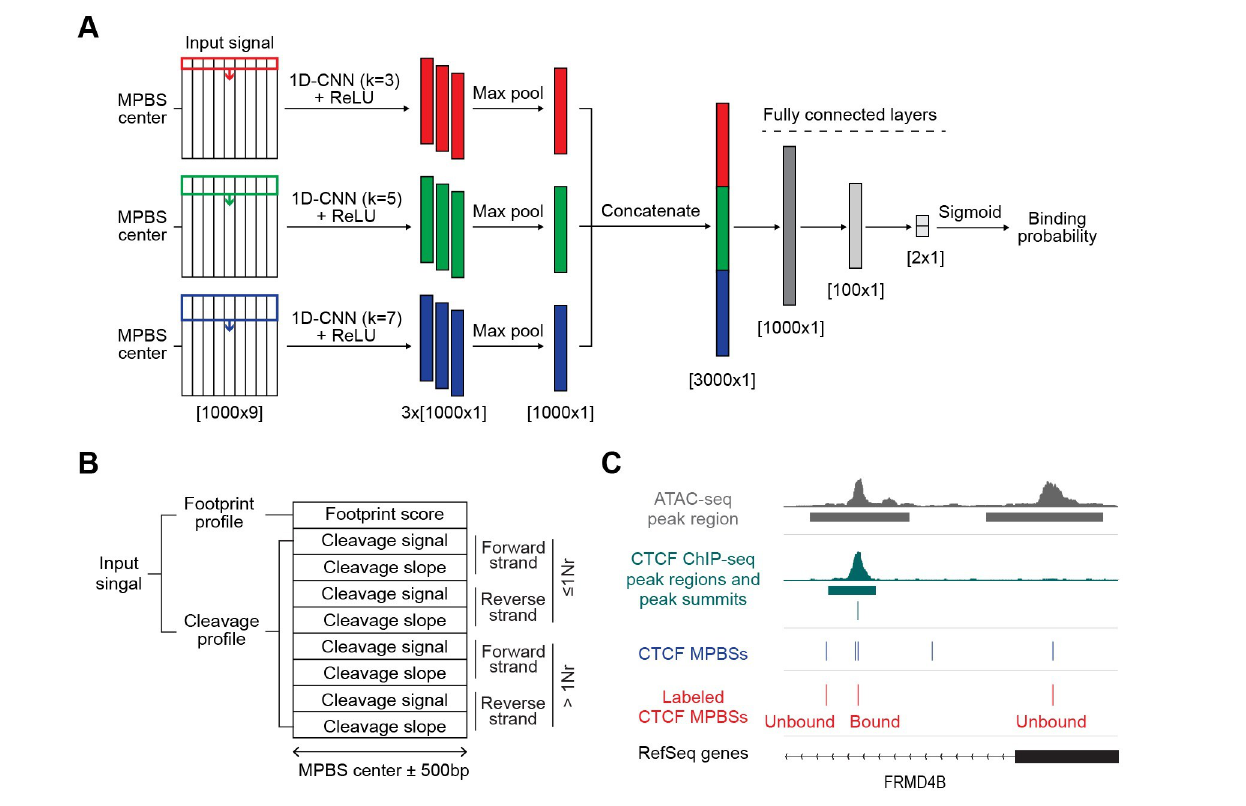
Fig 1. TAMC model and input signal. (A) Architecture of TAMC framework: three convolutional layers with 3 learnable filters of kernel sizes k = 3, 5, and 7, and ReLU activations, followed by max pooling, concatenation, and prediction of binding probability via a two fully connected layers with sigmoid activation. (B) Default TAMC input signal structure. > 1Nr, ATAC-seq read fragments larger than one nucleosome size; � 1Nr, ATAC-seq read fragments equal or smaller than one nucleosome size. (C) Representative tracks show strategy of labeling bound and unbound CTCF MPBSs in GM12878 cell type at FRMD4B gene locus. MPBS, motif-predicted binding